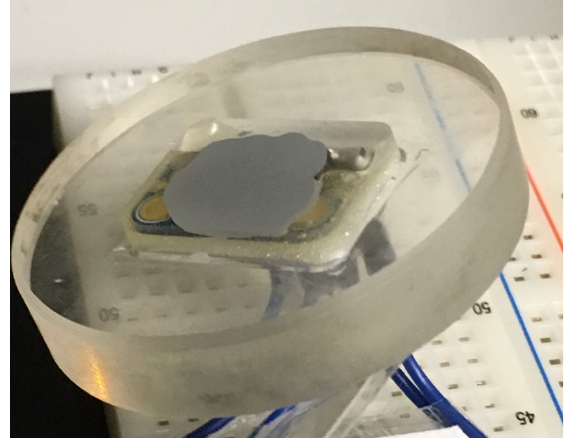
Figure 1: Glass sample with integrated digital tempera- ture sensor. The grey area represents the conductive paste between the glass and the sensor. The dimensions of the sensor are only 2 mm × 2